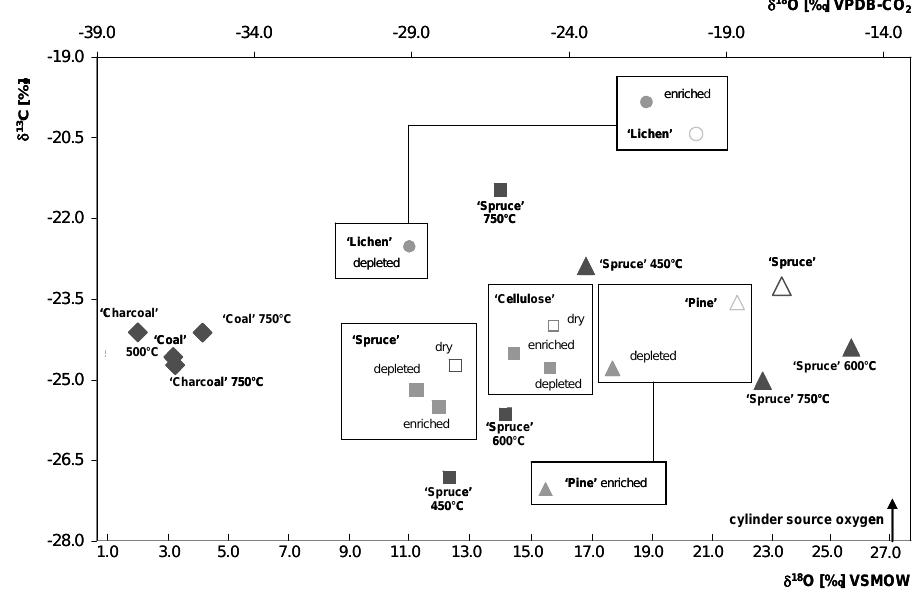
Fig. 4. Isotopic signature of combustion-derived CO 2 from experiments focussing on temperature relevance (dark symbols) and the impact of “plant moisture” (marked in boxes). Open symbols indicate the results from reference combustion runs at 750 ◦ C. The different kind of material is marked as follows: diamonds=fossil fuels, squares=wood/cellulose, triangles=needles, circles=lichen.